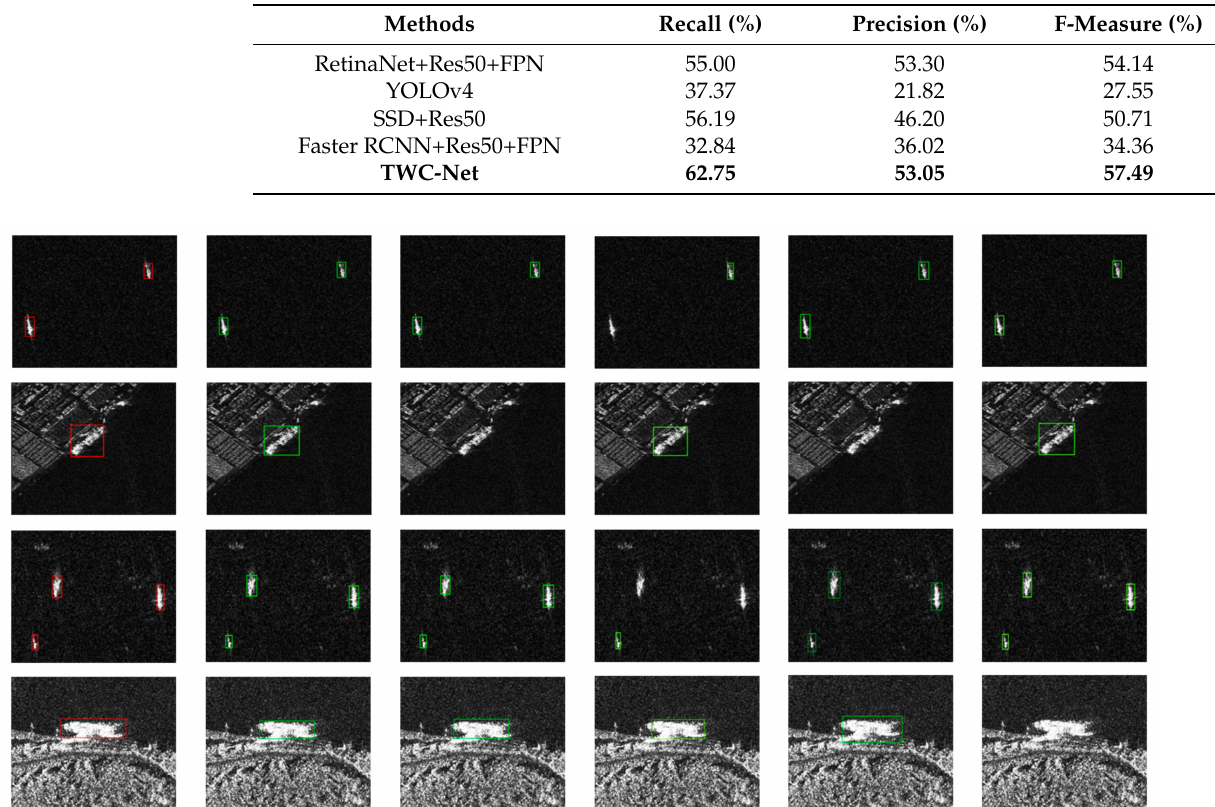
Figure 7. Comparison of the different detection methods; from left to right are ground truth, TWC-Net, RetinaNet, SSD, YOLOv4, and Faster